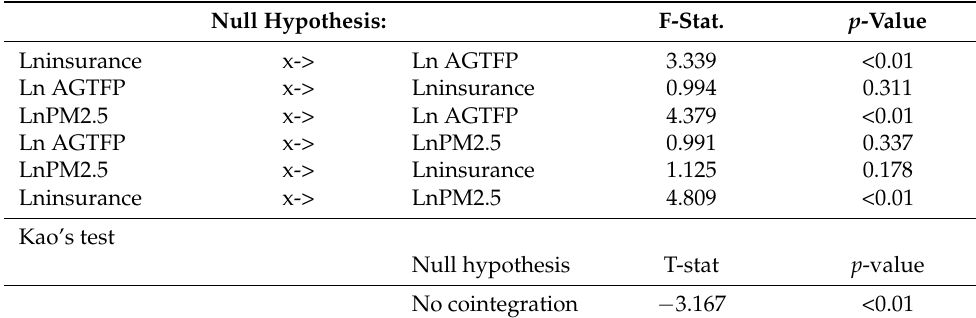
Table 4. Pairwise Granger causality analysis and Kao co-integration test. Null Hypothesis: F-Stat. p